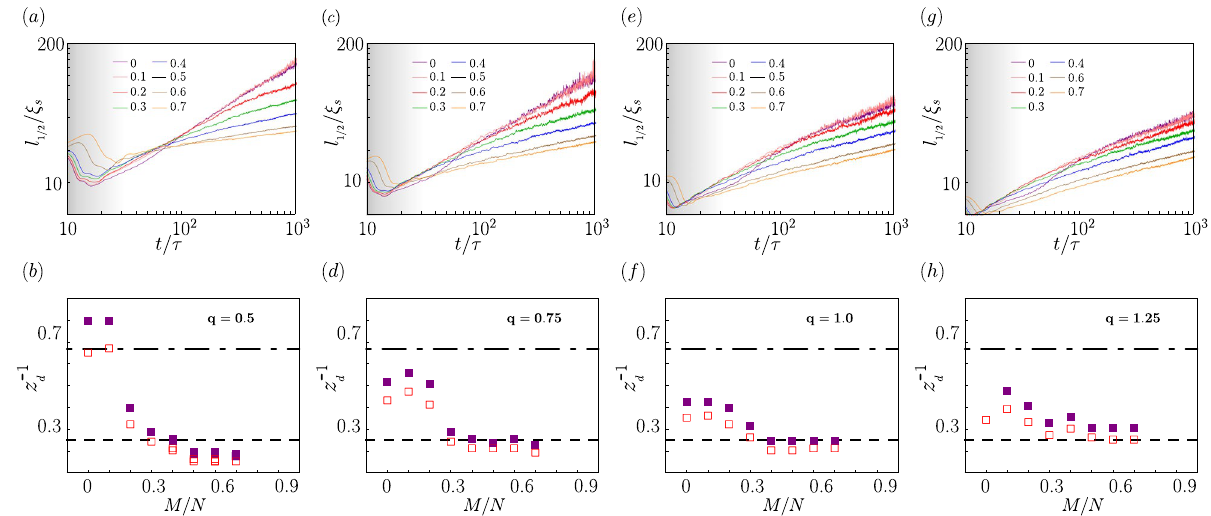
0.50 , (c) q 0.75 , (e) q 1.00 , (g) q 1.25 , and the Figure 6. Upper panels: l 1 / 2 /ξ s versus t /τ for ( a ) q = = = = ( t / ln t ) 1 / 4 fractional magnetization M / N values given in the legend. The dashed line indicates the scaling ∼ t 2 / 3 resulting from the vector model B, while the respective dot-dashed and dotted line indicate the scaling ∼ t 1 / 3 typical for the hydrodynamic model H. Bottom panels: The inverse of the dynamical exponent z − 1 and d ∼ extracted at long times from fitting the data shown in the corresponding upper panel. Open points demonstrate t 1 / z d to the numerical data, while the closed one by fitting the function results by fitting the function ∼ ( t / ln ( t )) 1 / z d ∼